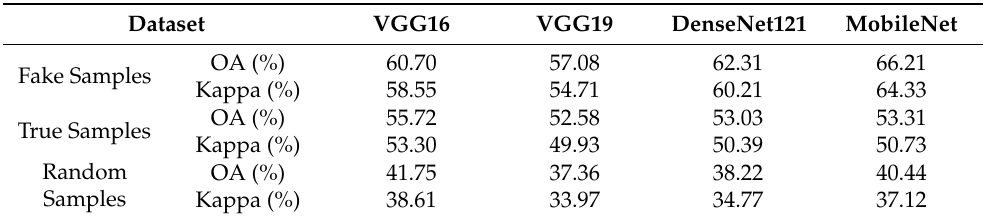
Table 2. Classification results of the different methods by three training datasets in UC Merced Land-Use